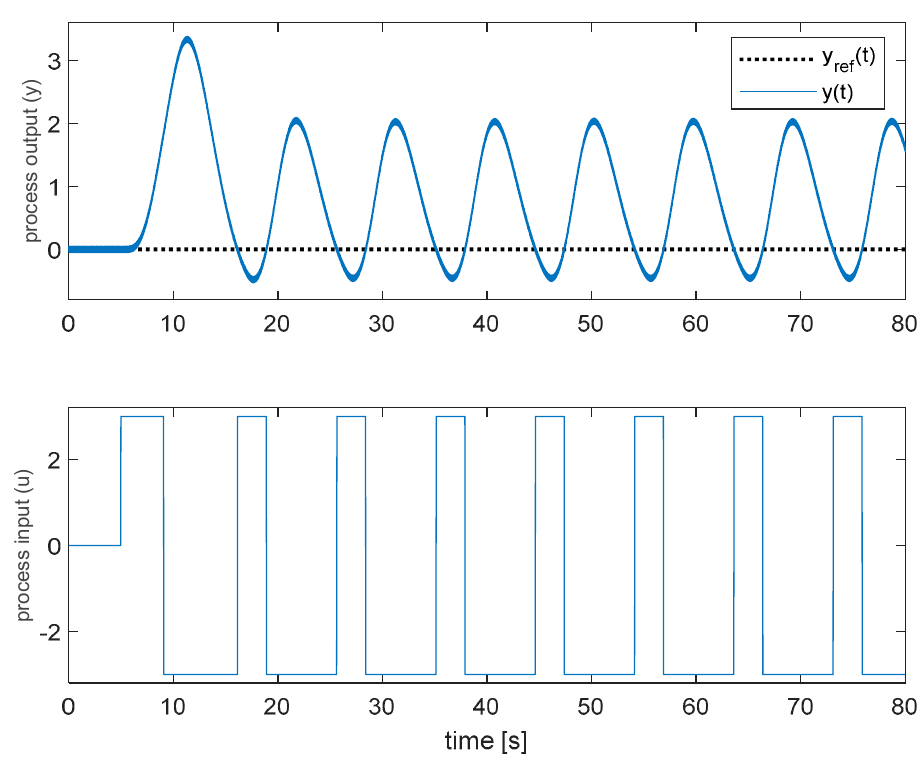
Figure 10. Response of the relay feedback method [1] for the high-order plus time-delay process with θ = 0.1 and PA set = − π .